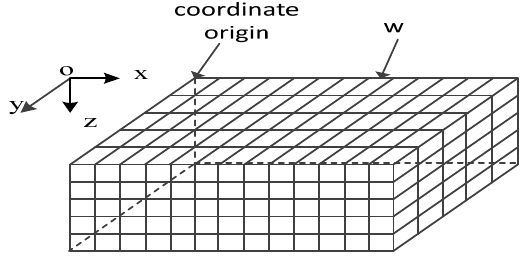
Figure 1. Coordinate system for UWSNs.